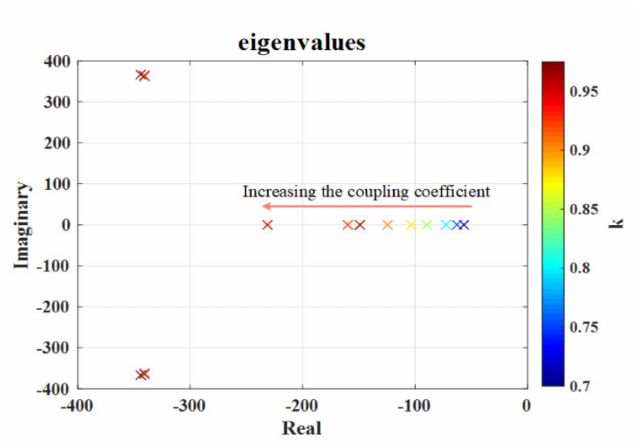
Figure 23. Dominant eigenvalues of the closed-loop system by changing the coupling coe ffi cient when the power of the first stack is equal to zero W and the other stacks inject the nominal power of 126 W. As seen in the previous results, the real part of the eigenvalues of the system has always a negative value of less than − 50. Therefore, the system is stable for a wide range of parameters change. This value depends strongly on the equalizer controller